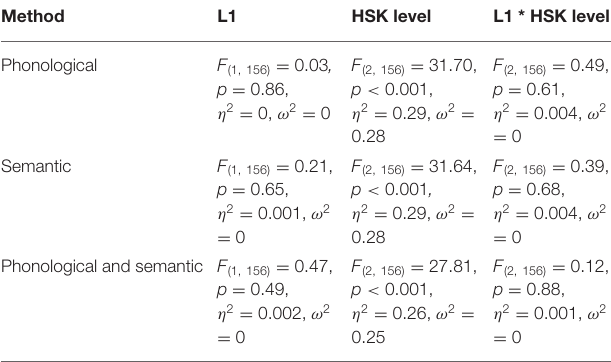
TABLE 7 | Summary of ANOVA tests for each measurement